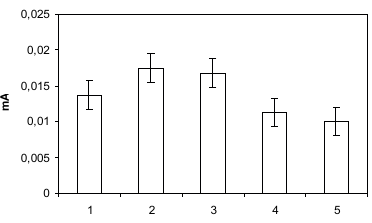
Figure 3. Dependence of the reduction peak of MDB after its interaction with oligos 1- MDB; 2 - Oligo